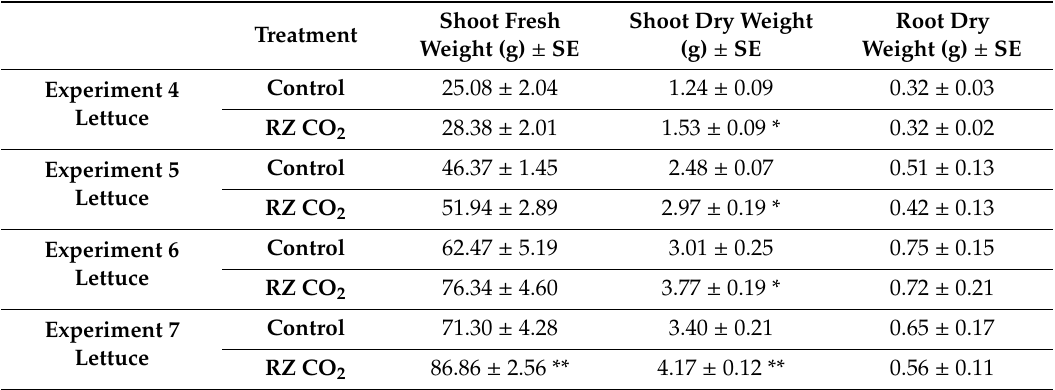
Table 5. Shoot fresh weight, shoot dry weight and root dry weight mean values of lettuce plants grown aeroponically. Experiments 4–7. Data are means ± SE of 8 replicates. Asterisks indicate significant di ff erences between treatments (* p < 0.05; ** p < 0.001).